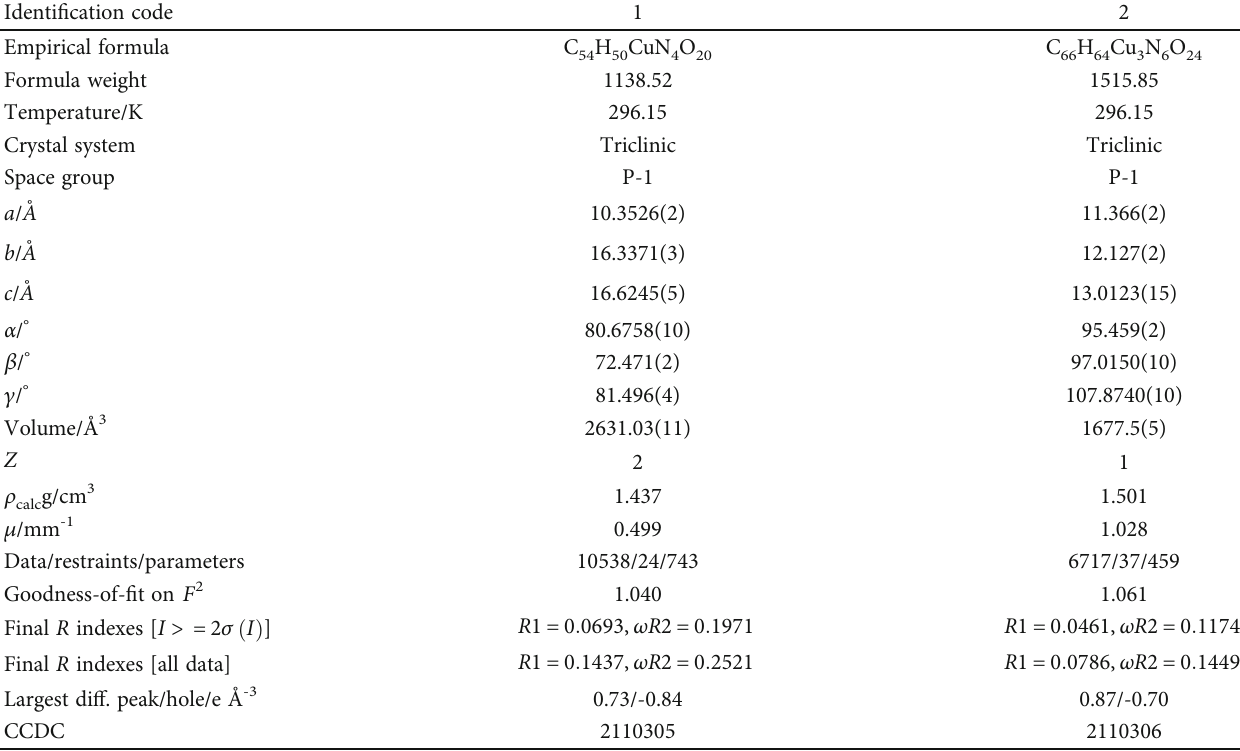
Table 1: The as-prepared compounds ’ re fi nements details along with their parameters of